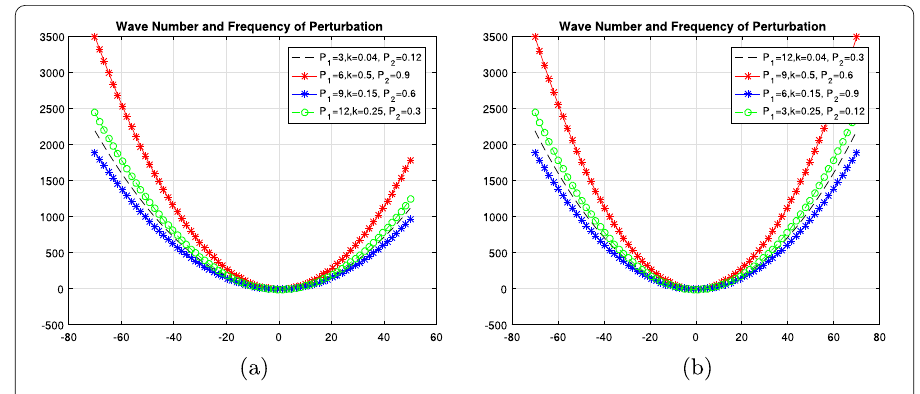
Figure 3 Frequency of the perturbation against the wave number with different parameter values